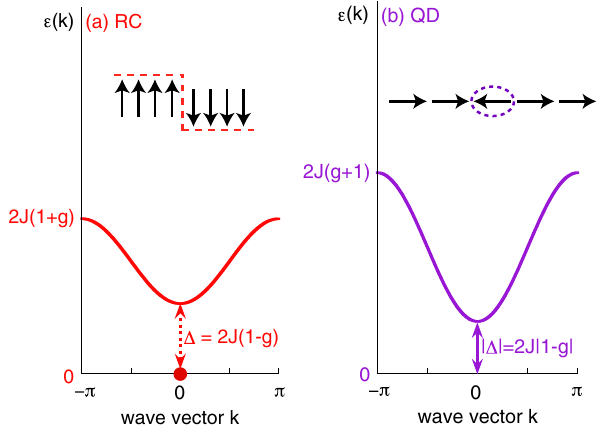
FIG. 6. (a) The two components of the spin excitation spectrum in the RC regime: the quasielastic peak at the origin (represented by a filled dot) and the propagating domain walls, as schemati- cally shown in the inset. The dispersion of the latter (solid curve) is ϵ ð k Þ ¼ J ½ 2 − 2 g cos ð k Þ þ O ð g 2 Þ(cid:2) , with an excitation gap Δ ¼ 2 J ð 1 − g Þ [6]. The quasielastic peak becomes a Bragg peak when ξ diverges toward the 1D ferromagnetic long-range order at T ¼ 0 . Since NMR is a low-energy probe, our 1 =T 1 data measured below h c ⊥ probe the quasielastic mode. (b) The spin excitation spectrum in the QD regime, ϵ ð k Þ ¼ Jg ½ 2 − ð 2 =g Þ cos ð k Þ þ O ð 1 =g 2 Þ(cid:2) with a gap j Δ j ¼ 2 j 1 − g j [6], which arises from the propagation of flipped spins (inset). Unlike the RC regime, there is no quasielastic peak.